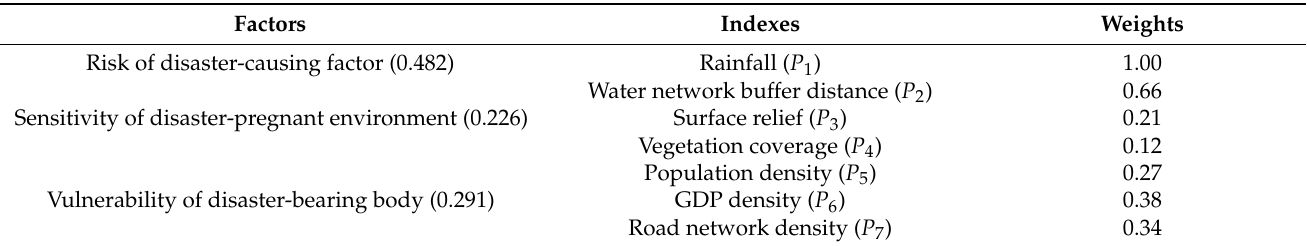
Table 3. Urban waterlogging risk assessment indicators and